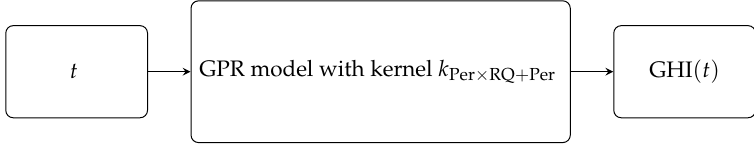
Figure 4. Time-based GPR model with kernel k Per